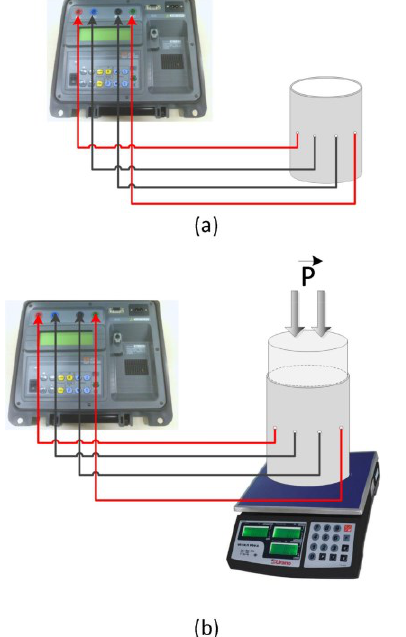
Fig. 4. PVC cell connected to electrical resistivity meter: (a) R m x w x δ and (b) R m x C x δ